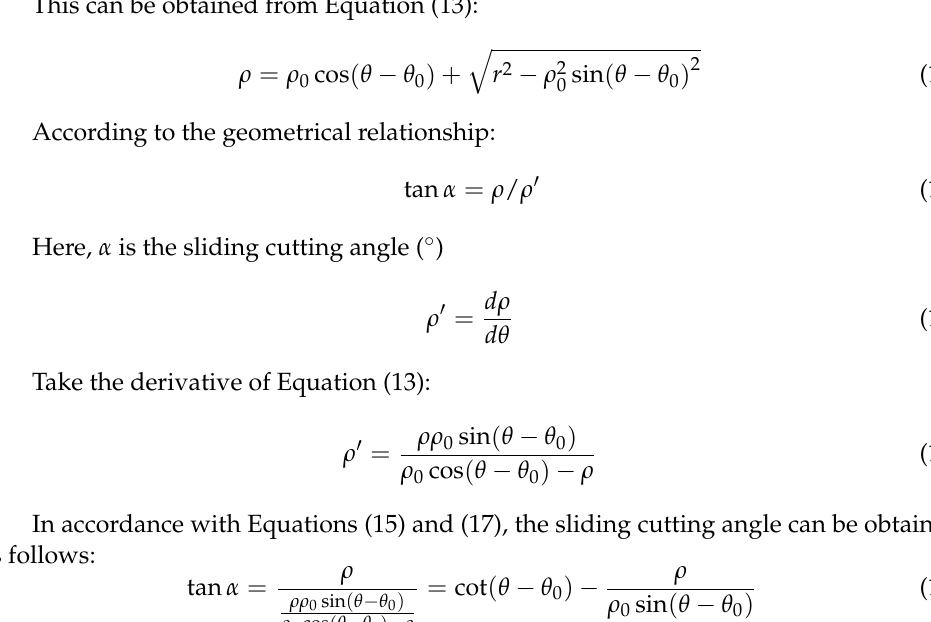
Figure 3. Structure of waved-type cutting disc. Point m is the cutting point of the stalk; v m is the forward speed of the harvester (m · s − 1 ); ω is the cutting disc angular speed (rad · min − 1 ). This can be obtained from Equation